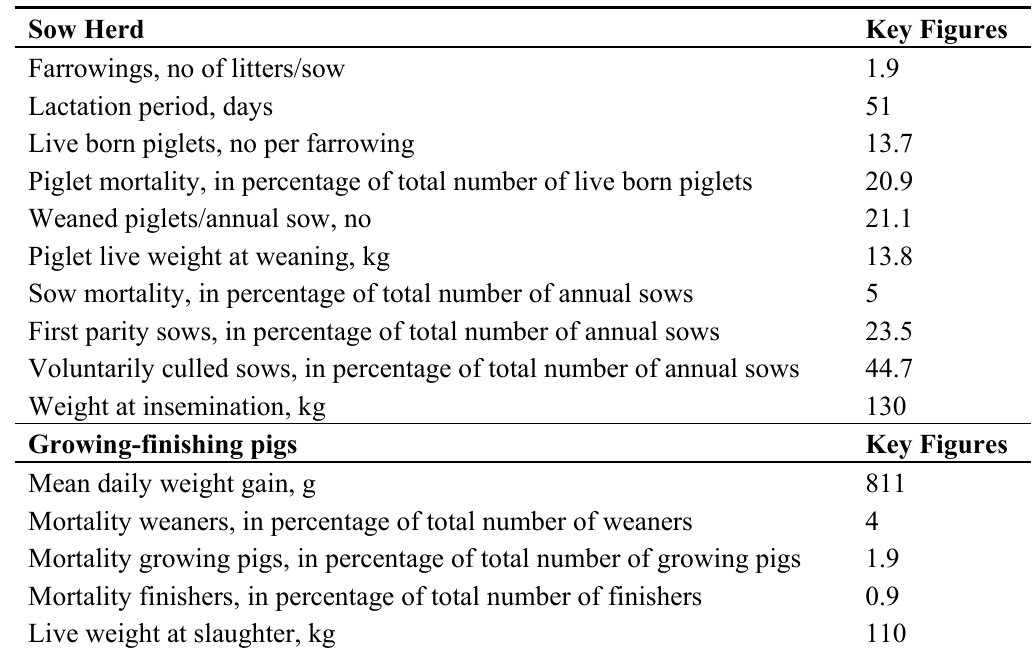
Table 2. Key figures for the sow herd and growing-finishing pigs in three organic pig production